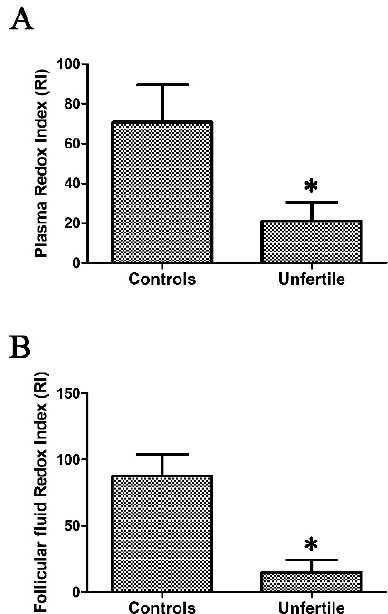
Figure 2. ( A ) Plasma redox index (RI) and ( B ) follicular fluid redox index values in infertile patients ( n = 45) and controls ( n = 45). * indicates that differences are statistically significant at the p < 0.05 level.